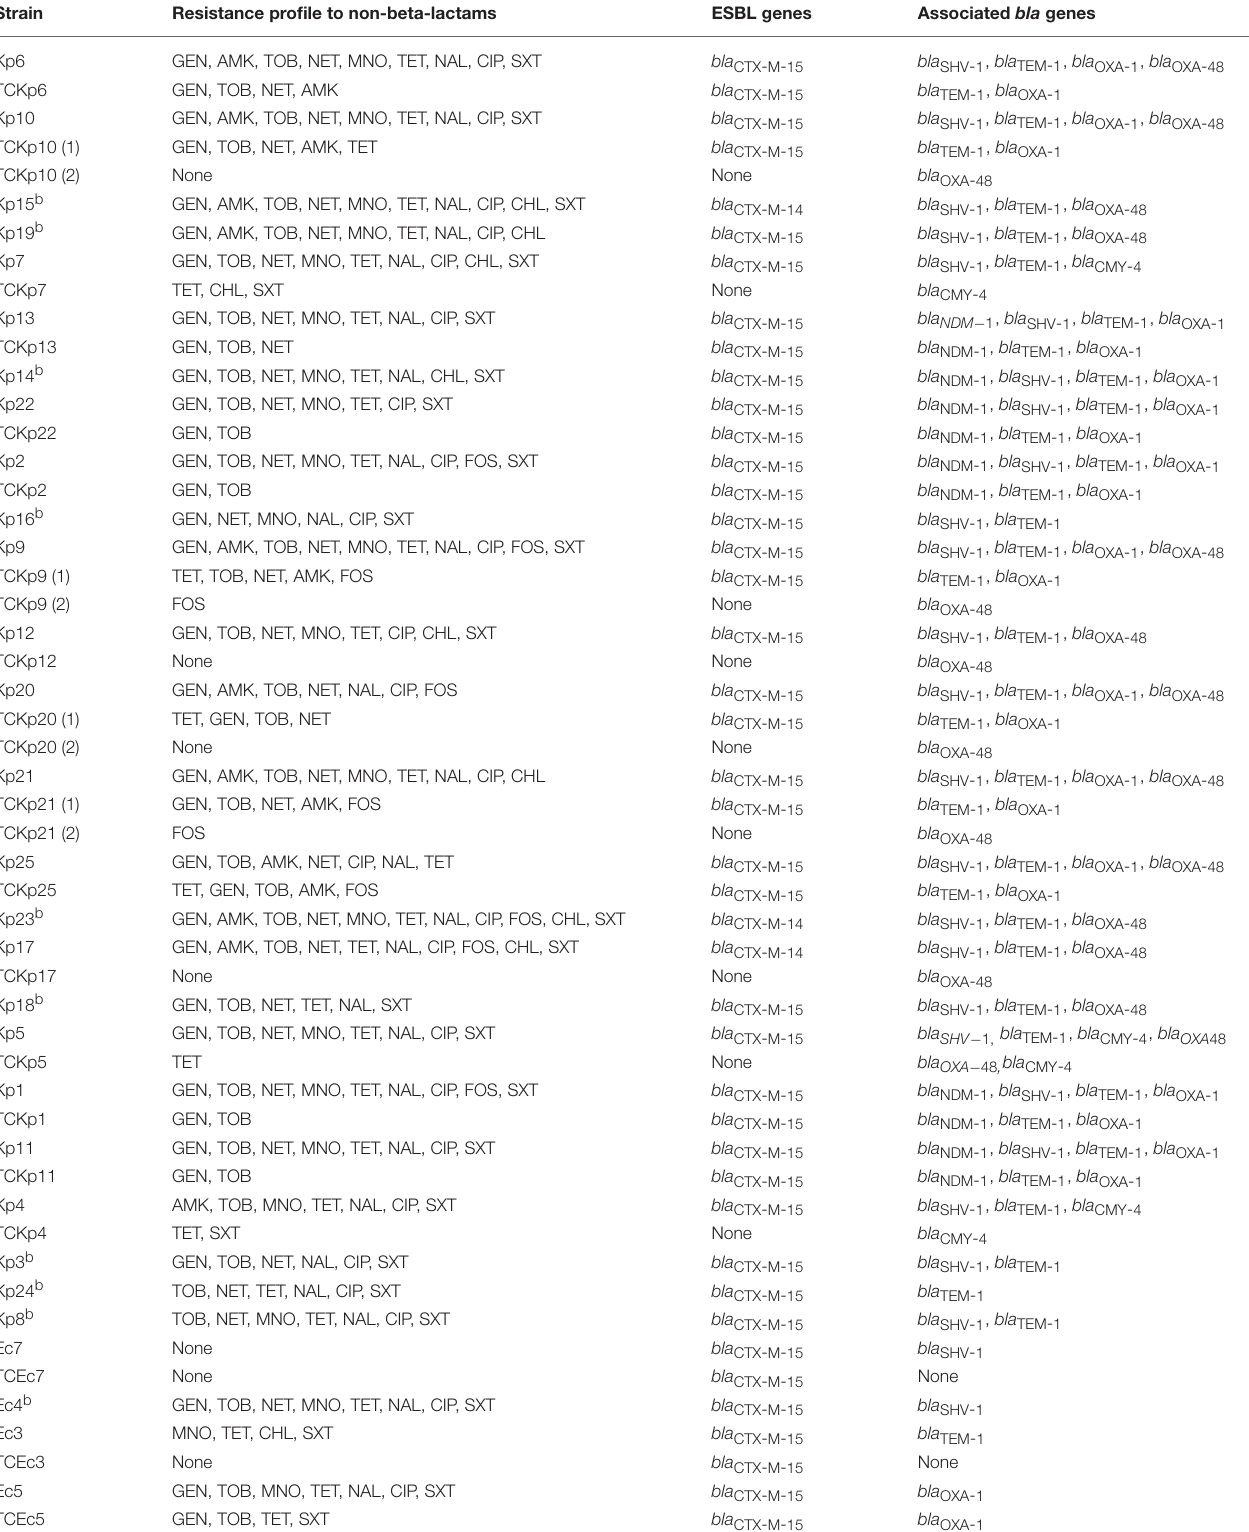
TABLE 3 | Characteristics of cefotaxime-resistant Enterobacteriaceae strains collected in intestinal flora of ICU-patients and their transconjugants. Strain Resistance profile to